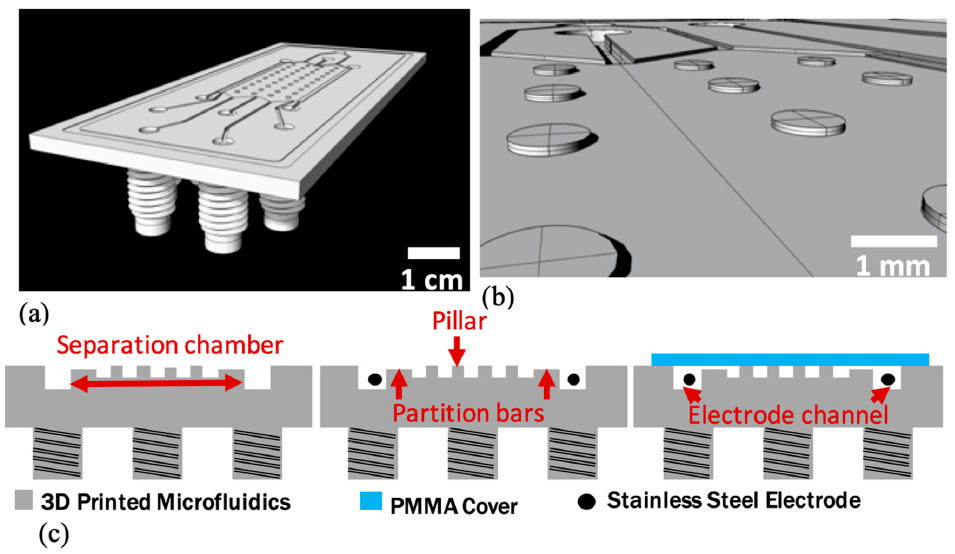
Figure 1. Chip layout: ( a ) the chip was composed of a separation chamber (30 mm long, 13 mm wide, 100 m high), two electrodes channels 500 µm deep, two inlets and five outlets with 3.2 mm of diameter. ( b ) Inset of the separation chamber: elliptic pillar arrays 1 mm × 0.8 mm × 0.1 mm and partition bars 50 µm deep between the separation chamber and the electrode channels. ( c ) Fabrication process flow: 3D printed microfluidics, electrode insertion and device bonding.